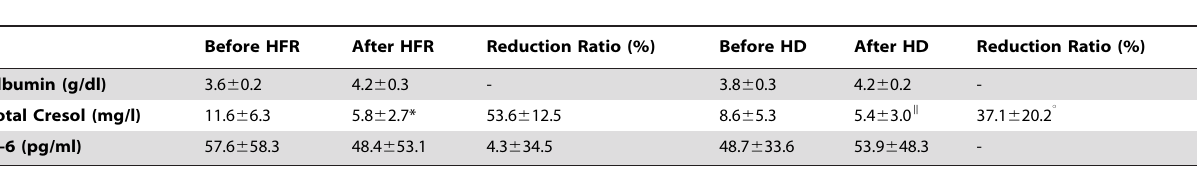
Table 3. Serum albumin, and plasma total cresol and Il-6 concentrations before and after either HFR or HD.